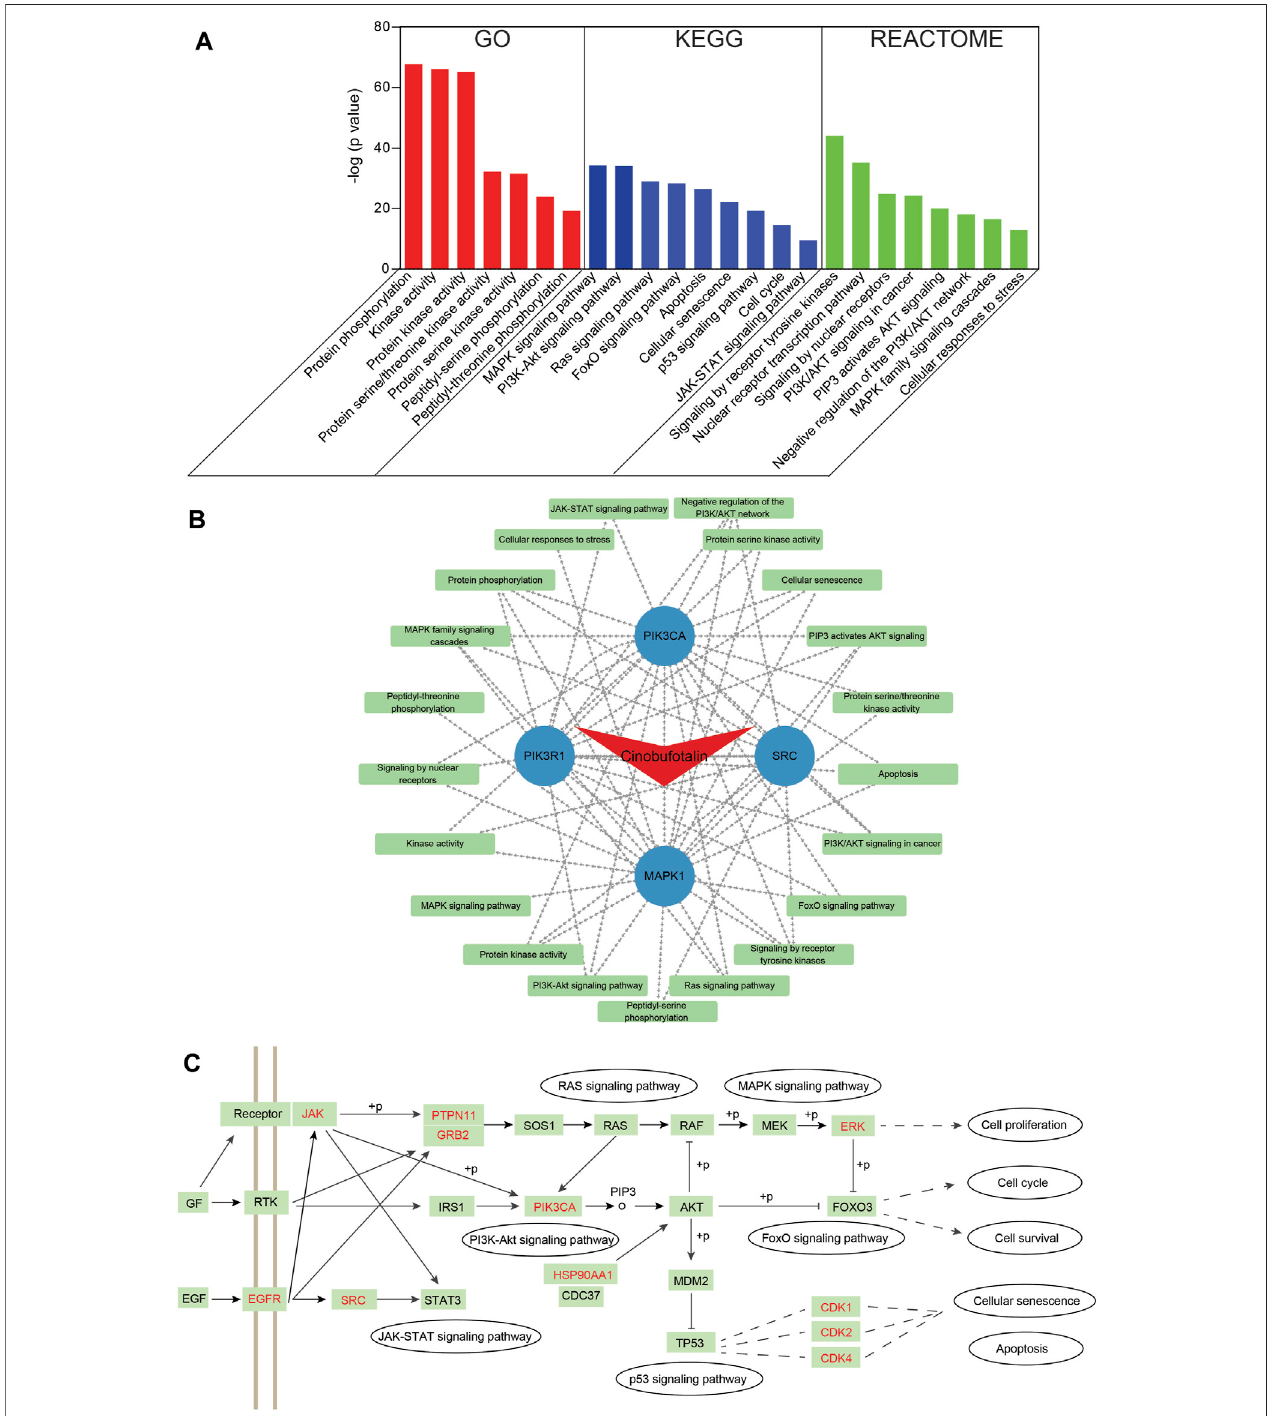
FIGURE 4 | Functional characterization of cinobufotalin against COAD intersecting genes (A) GO, KEGG and Reactome enrichment analysis was conducted for intersecting genes using Metascape tools (B) The drug-target protein-pathway network was constructed using Cytoscape (C) The integrated pathways map of cinobufotalin against COAD. “ +p ” stands for phosphorylation modi fi cation. The targets marked in red are the predicted targets of cinobufotalin.